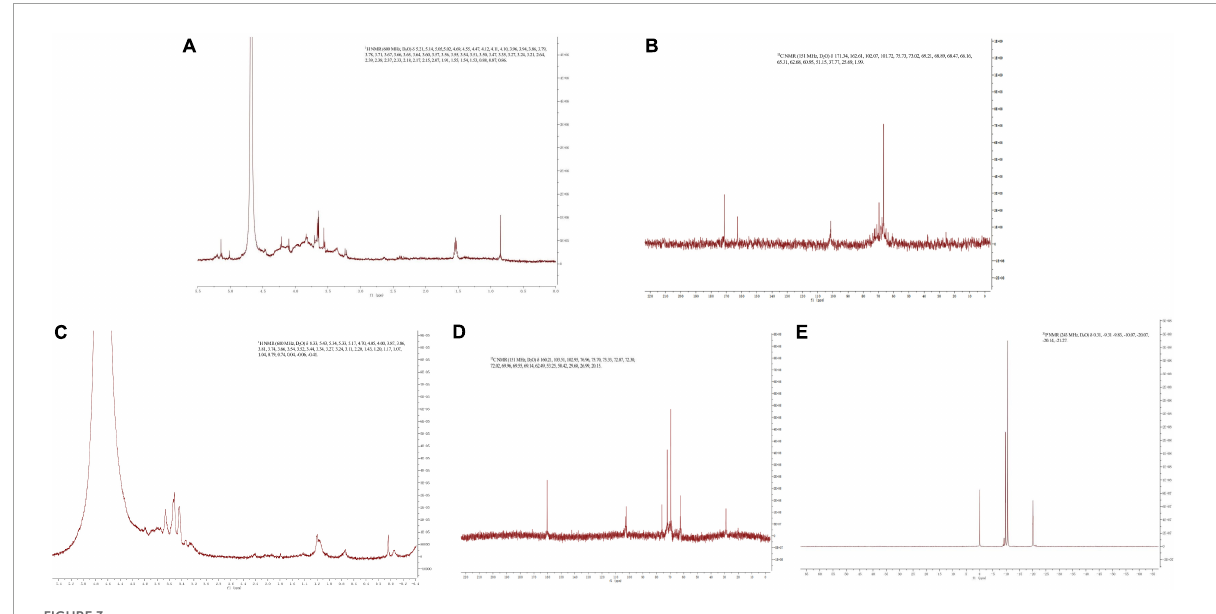
FIGURE3 1 H NMR spectra of SPN (A) and PPN (C) , 13 C NMR spectra of SPN (B) and PPN (D) , and 31 P NMR spectra of PPN (E)